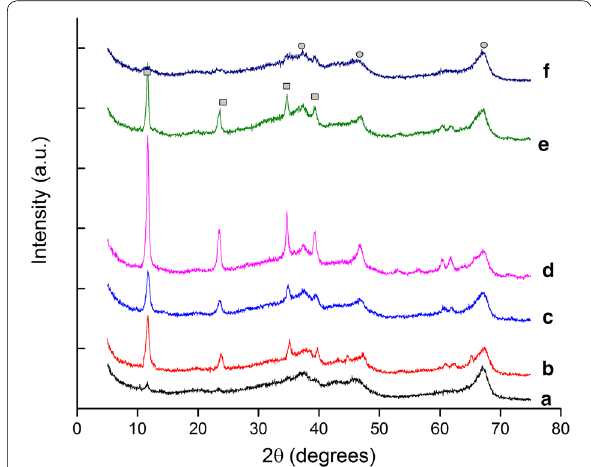
Fig. 3 XRD patterns for the prepared catalysts. (a) MgO/γ-Al 2 O 3 ; (b) 0.5 Zn/Mg; (c) 1 Zn/Mg; (d) 1.5 Zn/Mg; (e) 2 Zn/Mg and